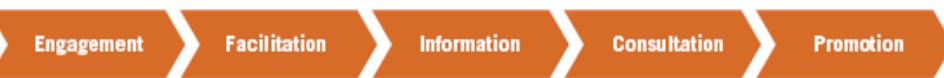
Source: D'Onofrio, Sharon. 2010. "Policy Advocacy: A Toolkit for Microfinance Associations." Washington, DC: SEEP